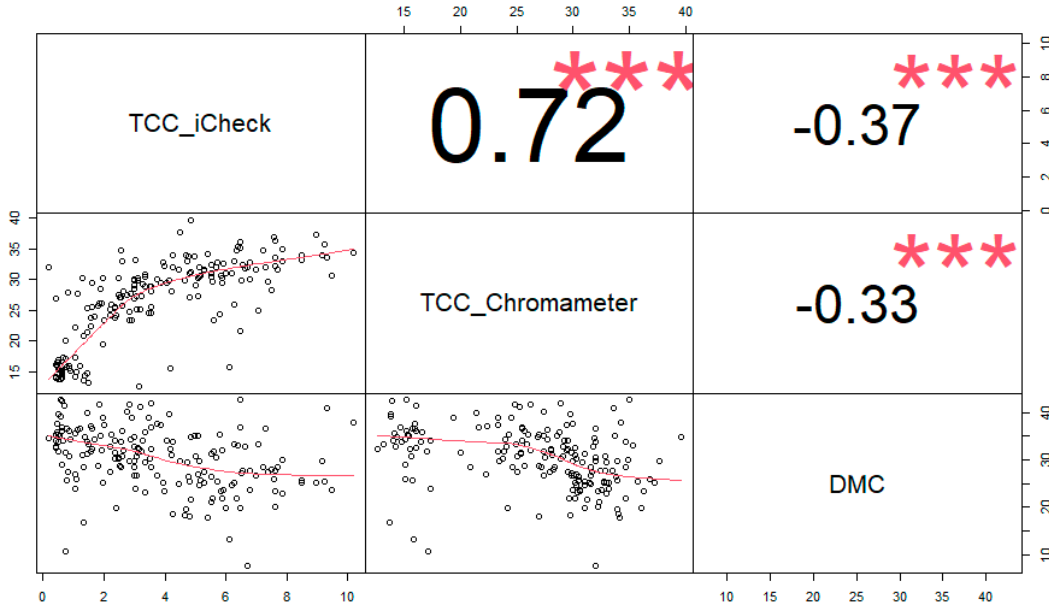
Figure 1. Trait association between total carotenoid content (TCC) (measured with iCheck (TCC_iCheck) and Chroma Meter (TCC_Chroma Meter)) and root dry matter content (DMC).